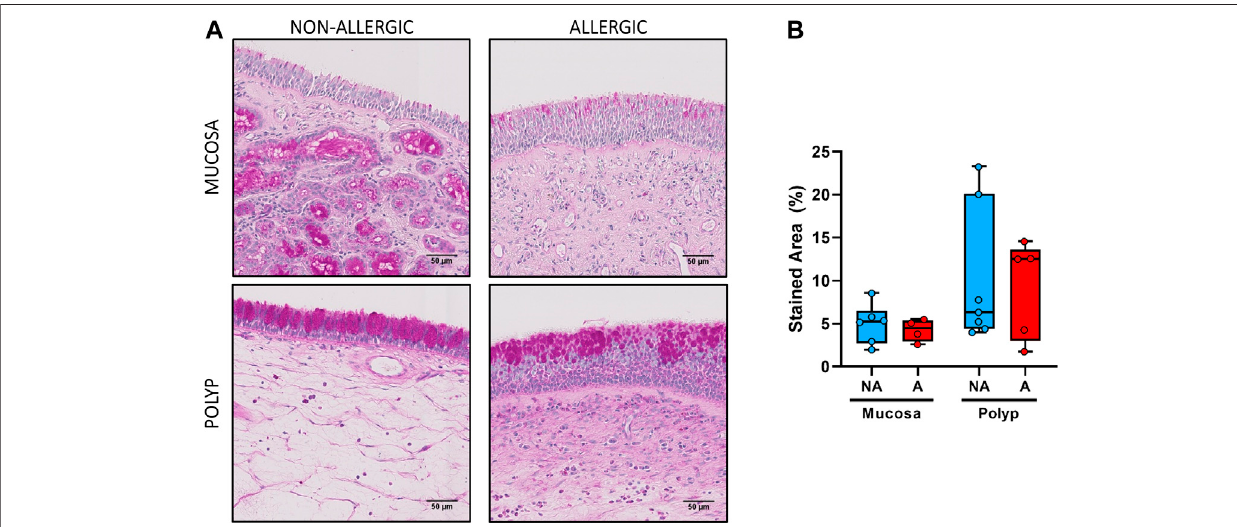
FIGURE 7 | Analysis of goblet cell hyperplasia in nasal polyps and nasal mucosa. (A). Representative images of PAS staining in nasal mucosa ( n (cid:2) 10) and nasal polyps ( n (cid:2) 12) in all experimental groups (mucopolysaccharides: pink, nuclei: purple, scale bar (cid:2) 50 μ m). B. Comparison of the PAS-positive (pink) stained area in the epithelium of nasal polyps and nasal mucosa samples between non-allergic CRSwNP (NA) and allergic CRSwNP (A) patients. Results are presented as mean ± SEM. Mann-Whitney U test was used to state signi fi cant differences. Only samples with suf fi cient epithelial integrity were included in this analysis.